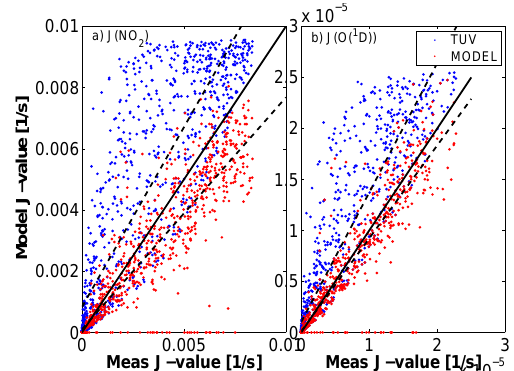
Figure 8. Scatter plots of the measured versus the SOSAA modelled (red dots) and the TUV (Tropospheric Ultraviolet and Visible Ra- diation Model, blue dots) predicted above-canopy photolysis rates for (a) NO 2 → NO + O and (b) O 3 → O ( 1 D ) + O 2 . The solid lines indicate the 1:1 reference line, whereas the broken lines represent the least-squares